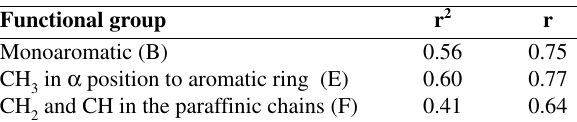
Table 2. Correlation coefficients obtained for selected functional groups.